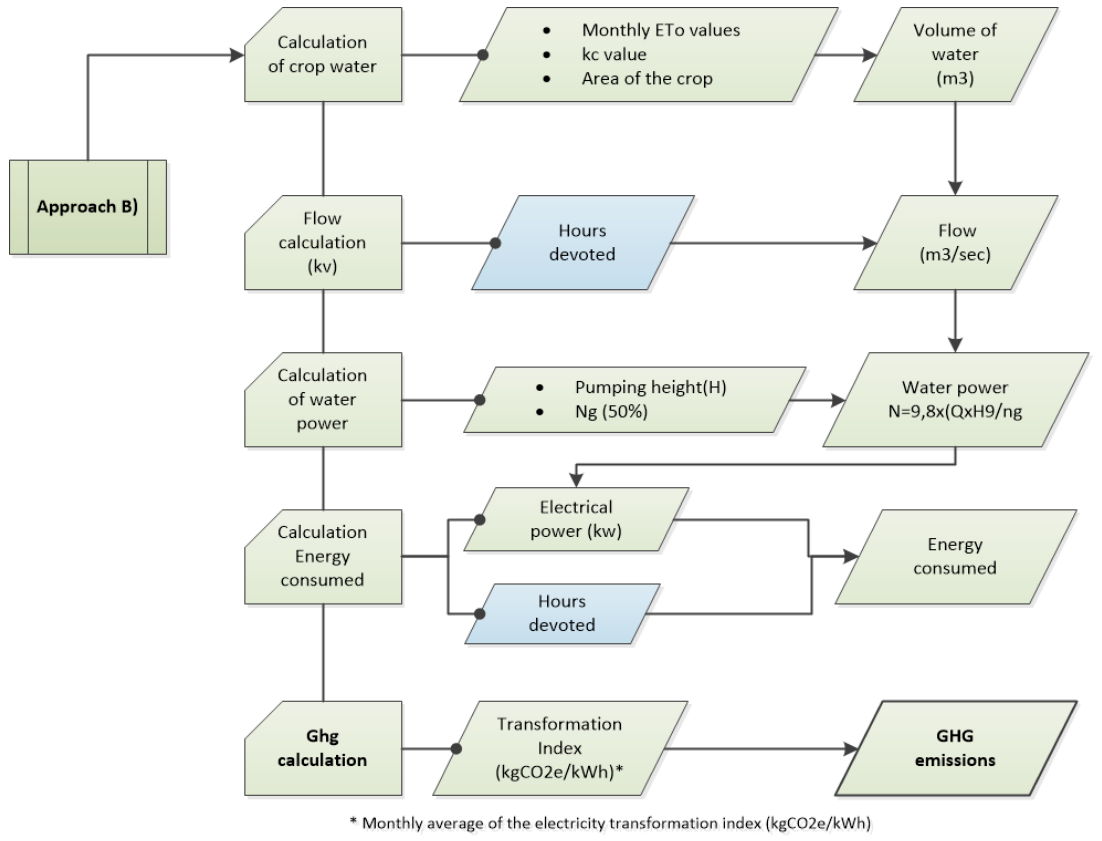
Figure 2. Approach B. This is based on maximum water demand of crops and its transformation in energy and the subsequent GHG emissions.